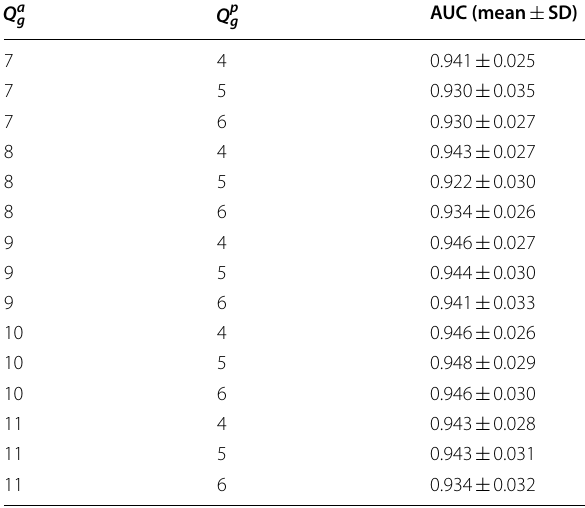
Table 4 AUC scores of GAV (or T and 66 and the t -th root is set to be